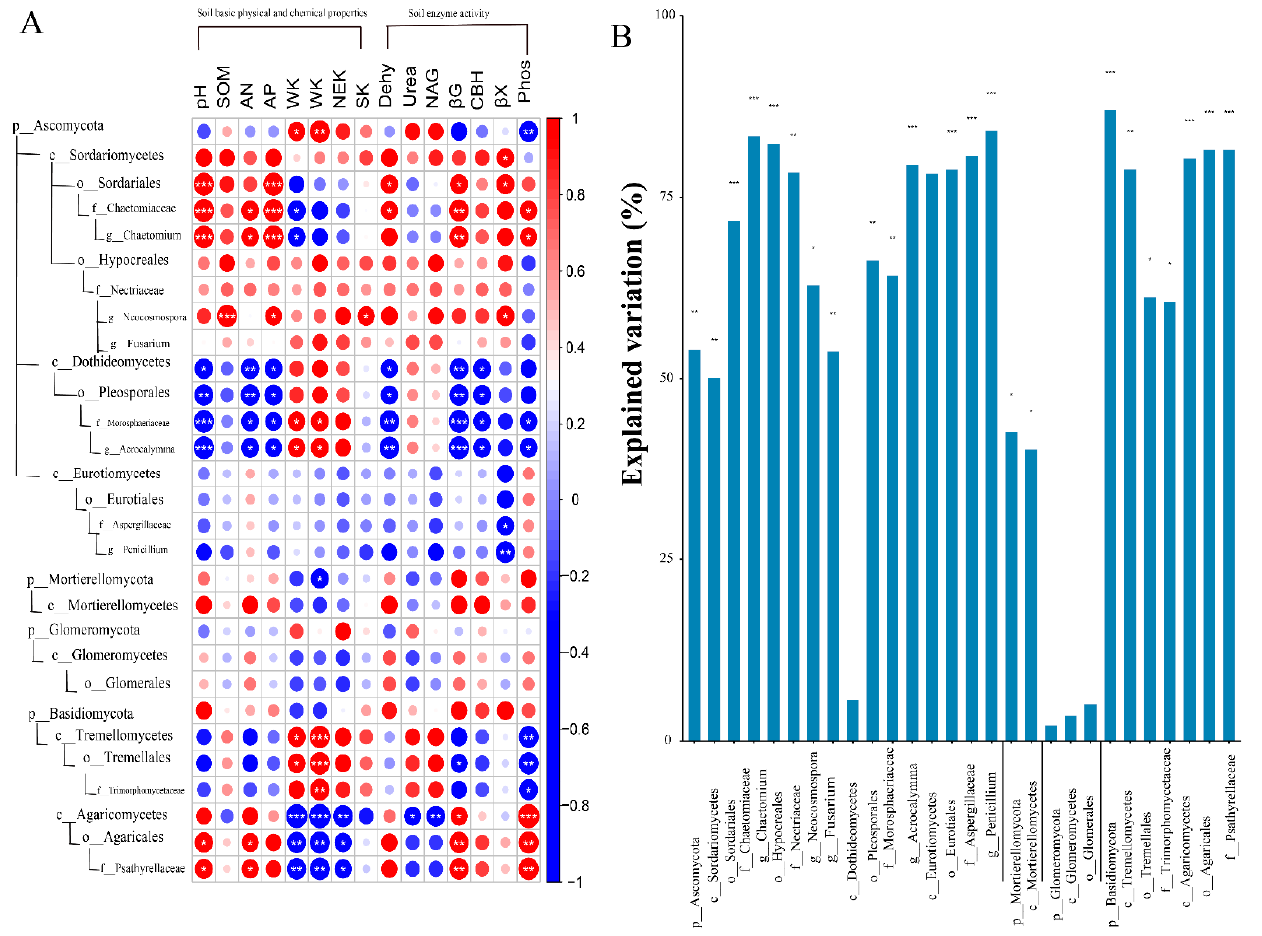
Figure 4. Panel ( A ) shows the heatmap of Spearman’s rank correlation coefficients between relative abundances of major fungal taxa from phyla to genera (dominance of the relative abundance on average) and soil properties. *** Correlation is significant at the 0.001 level. ** Correlation is significant at the 0.01 level. * Correlation is significant at the 0.05 level. Blue indicates negative correlation, and red indicates positive correlation. Panels ( B ) shows the stepwise multiple regression (SMR) showing the total explanation rate of environmental variables to the richness of each species. *** Correlation is significant at the 0.001 level. ** Correlation is significant at the 0.01 level. * Correlation is significant at the 0.05 level.